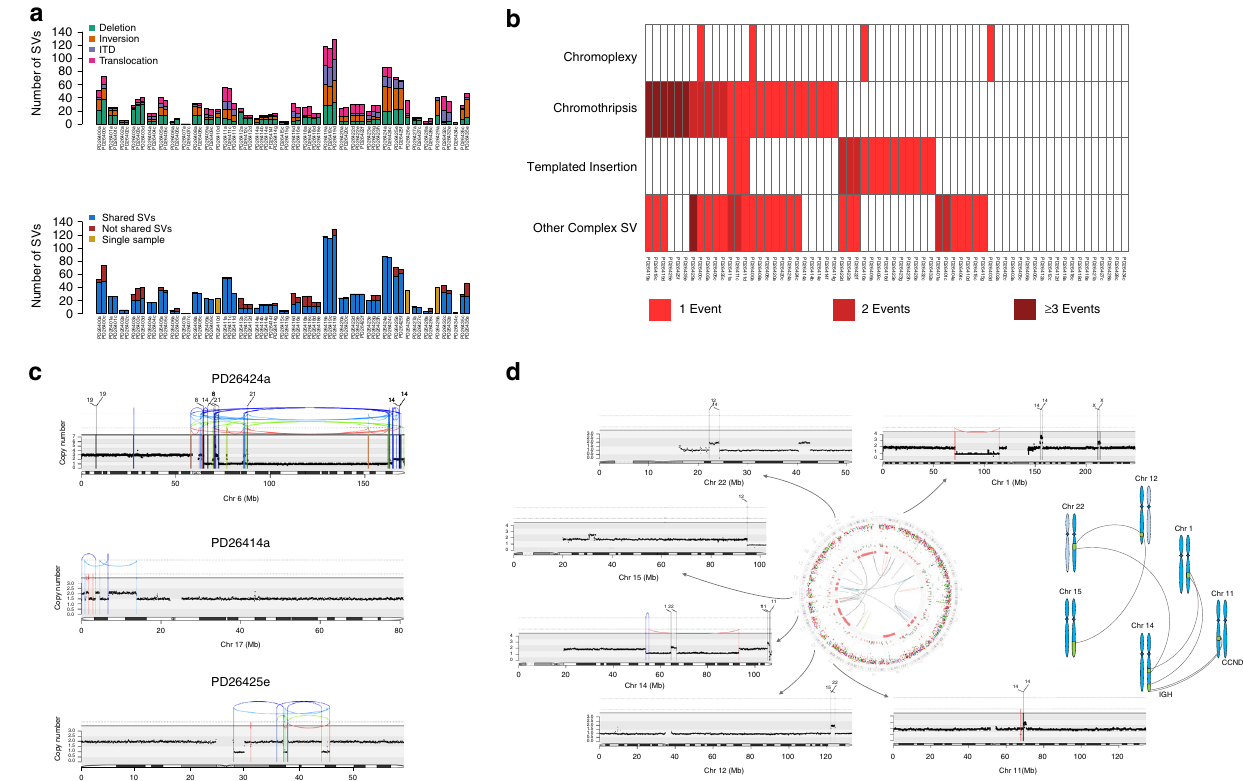
Fig. 2 The landscape of structural variants (SVs) in MM. a Top, prevalence of SVs across the entire series. Bottom, the proportion of SVs shared between samples collected at different time points within the same patients. b A heatmap representing the distribution and prevalence of the main complex events: chromothripsis, chromoplexy, and templated insertions. c Three examples of chromothripsis. In these plots, the red arch represents a deletion, the green arch represents an internal tandem duplication (ITD) and the blue arch represents an inversion. d Example of templated insertion. In the middle, the genome plot of patient PD26422 represents all main genomic events: mutations (external circle), indels (middle circle; dark green and red lines represent insertions and deletions respectively), copy-number variants (red = deletions, green = gain) and rearrangements (blue = inversions, red = deletionss, green = ITDs, black = translocations). Externally, a copy-number/rearrangement plot of each chromosome involved in the templated insertion is provided, highlighting a focal CNA around each breakpoint. This case represents a clear example of how templated insertion may involve critical driver